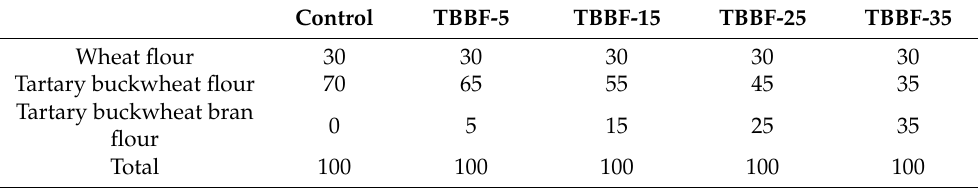
Table 1. Flour ratios of TBDNs with different substitutions of Tartary buckwheat bran flour. Control TBBF-5 TBBF-15 TBBF-25 TBBF-35 Wheat flour 30 Tartary buckwheat flour 70 Tartary buckwheat bran flour